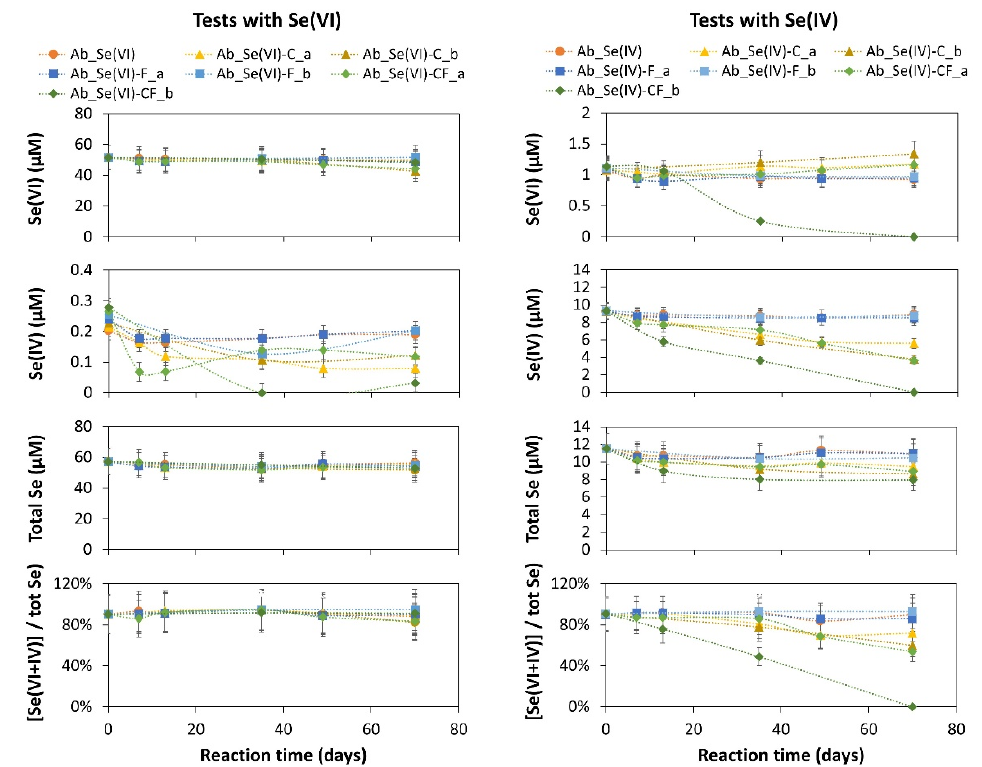
Figure 2. Abiotic test results for Se(VI) (left) and Se(IV) (right) reactivity in the presence of Opalinus Clay (C) and/or stainless steel filter (F). Details of the test conditions can be found in the legend and in Table 2. The error bars represent the measurement uncertainty (95% confidence).